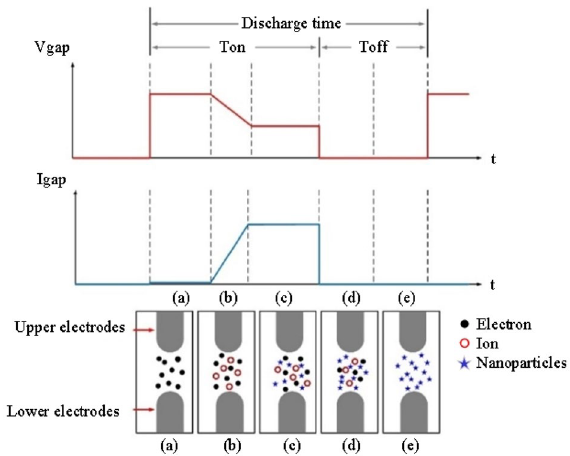
Figure 2. ESDM process: ( a ) voltage generation, ( b ) ionization effect, ( c ) melting effect, ( d ) termination of electric discharge, and ( e ) recovery of